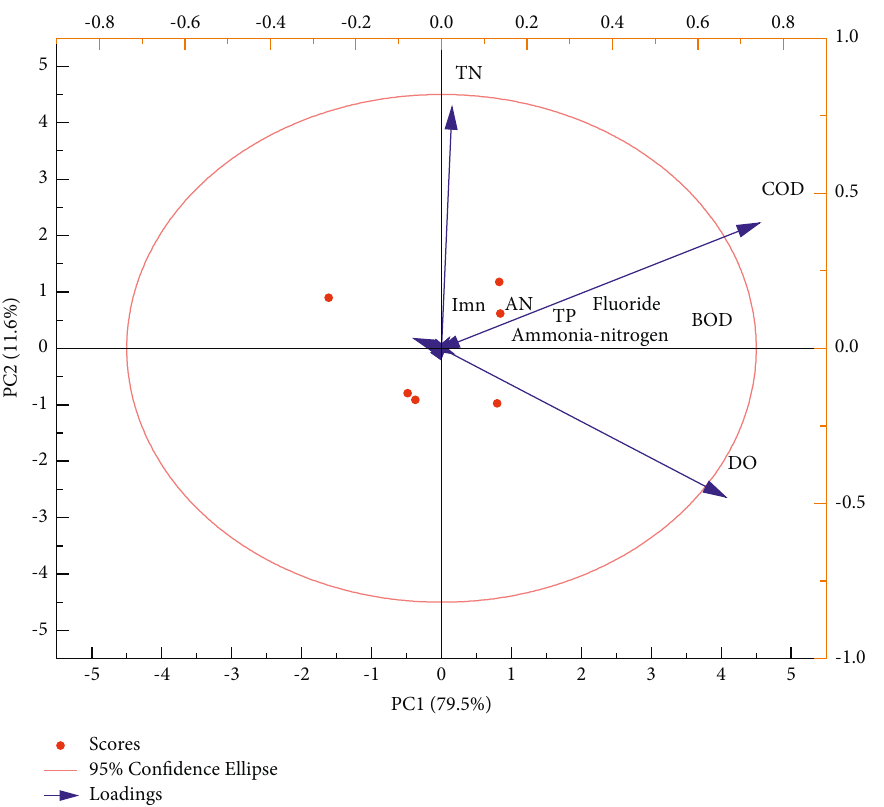
Figure 5: Principal component analysis on water quality of the Ningxia section of the Yellow River in